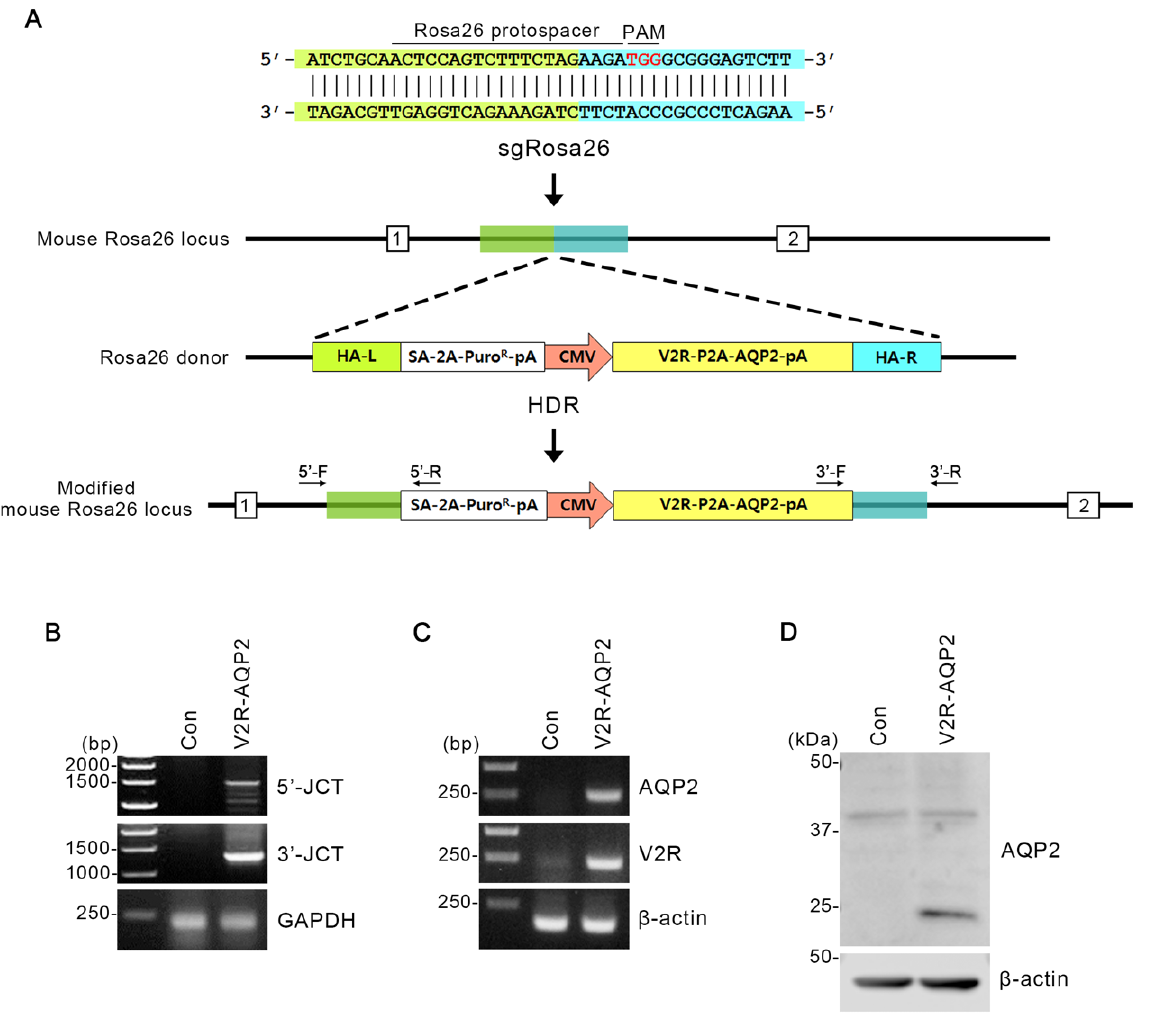
Figure 1. Integration of V2R-AQP2 expression cassette into the Rosa26 locus using CRISPR/Cas9 genome-engineering technology in mpkCCDc14 cells. ( A ) Schematics of integration into the Rosa26 locus in mpkCCDc14 cells. Protospacer targeting the Rosa26 locus and the PAM element were indicated. The Rosa26 homology-directed repair (HDR) donor vector included homology arms (HAs) of 0.8 kb flanking a SA-2A-puromycin element and the V2R-P2A-AQP2 expression cassette. HA-left (L) was indicated in green and HA-right (R) was in blue. Two different junction PCR sites ( 3′ - and 5′ -junction) were depicted. ( B ) Junction PCR analysis in V2R-AQP2 cells to identify the targeted integration of Avpr2 and Aqp2 genes. PCR with 5′ -F/ 5′ -R and 3′ -F/ 3′ -R primers amplified the 5′ -junction PCR product (1477 bp) and 3′ -junction PCR product (1271 bp) of the V2R-AQP2 cells. ( C ) PCR showing the expression of AQP2 and V2R in control mpkCCDc14 cells and V2R-AQP2 cells. The predicted PCR product size of AQP2 and V2R were 245 bp and 216 bp, respectively. ( D ) Immunoblotting of AQP2 in control mpkCCDc14 cells and V2R-AQP2 cells. PAM, protospacer adjacent motif; HA-L, homologous arm-left; HA-R, homologous arm-right; pA, poly A; Puro, puromycin resistance gene; CMV, cytomegalovirus promoter; HDR, homology-directed repair; 5′ -JCT, 5′ -junction; 3′ -JCT, 3′ -junction; Con, control mpkCCDc14 cells; V2R-AQP2, mpkCCDc14 cells constitutively expressing V2R and AQP2 via CRISPR/Cas9-mediated genome engineering technology.